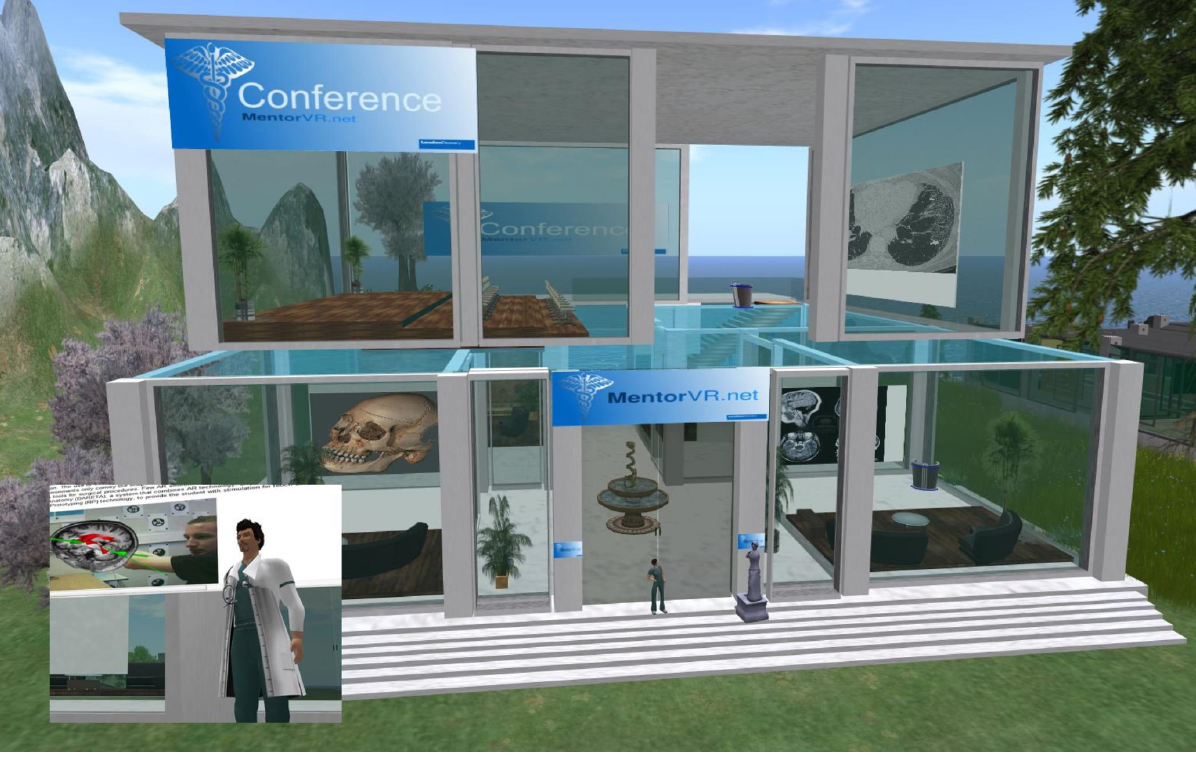
Figure 1. Photograph from Second Life showing the MentorSL meeting complex. Licensed under Creative Commons Attribution